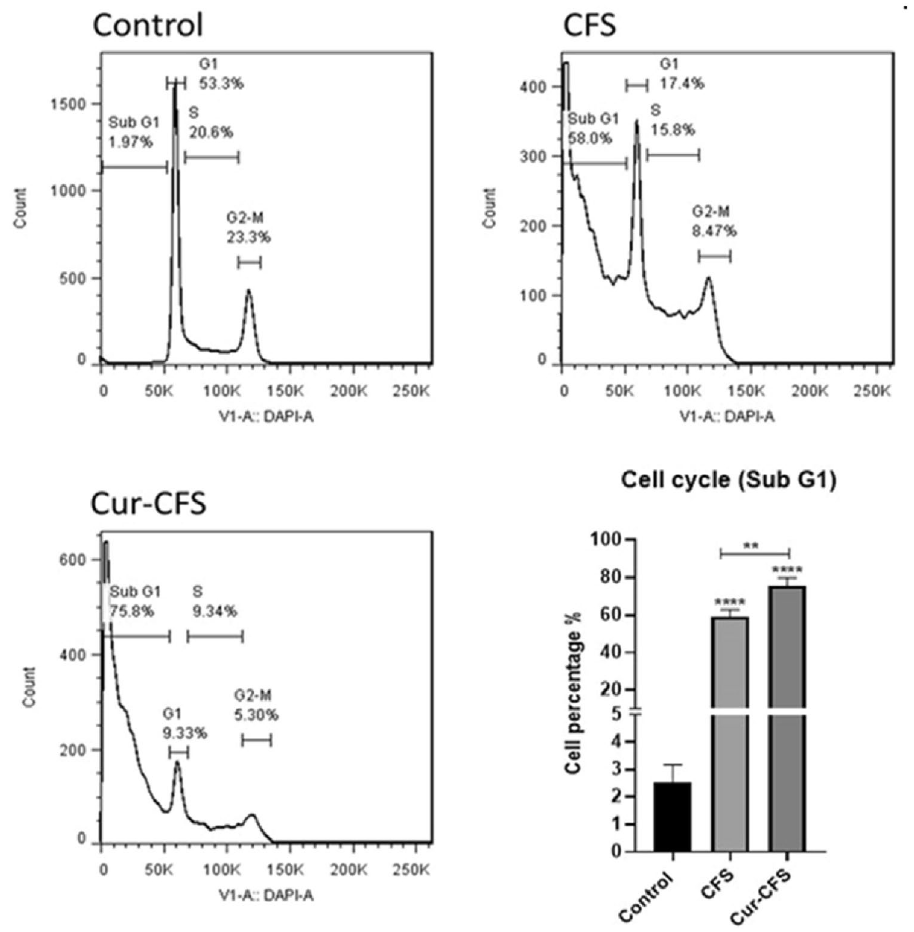
Figure 5. Cell cycle analysis shows the population of cells inters to the Sub-G1 phase in CFS and cur-CFS- treated cells compared to the control group ( p ˂ 0.0001).